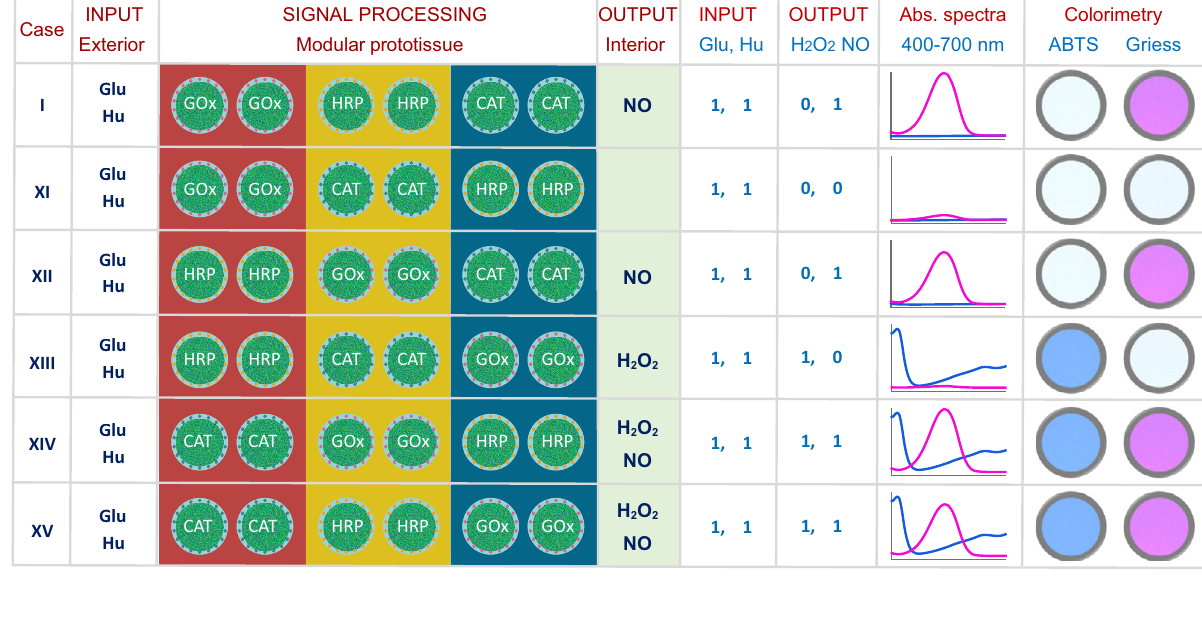
Fig. 4 | Spatial organization and signal processing in dual input model proto- tissues. Six different three-layer sequence arrangements of enzyme-CV hydrogel modules (case I (standard con fi guration; alternative con fi gurations (cases XI-XV)) operating under dual substrate inputs are shown. Outputs in the interior lumen include NO (I and XII), H 2 O 2 (XIII), or mixtures of H 2 O 2 and NO (XIV and